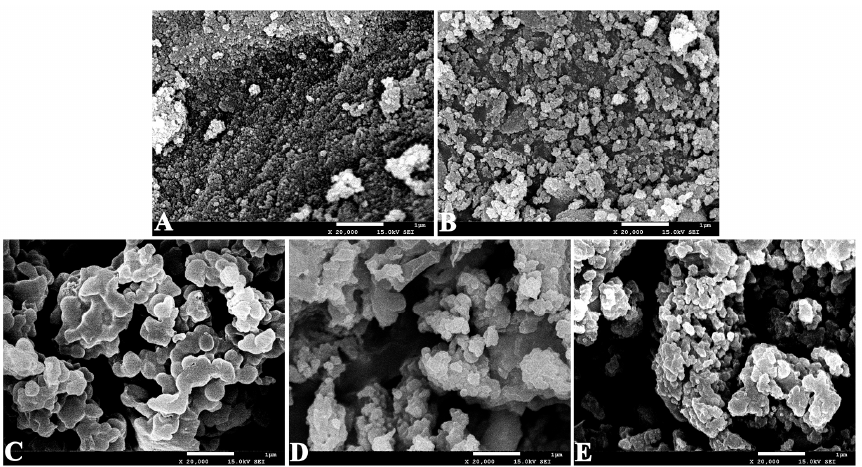
Figure 4. SEM images of ( A ) Fe 3 O 4 nanoparticles; ( B ) APTES-functionalized Fe 3 O 4 nanoparticles; ( C ) RML CLEAs; ( D ) magnetic RML CLEAs; ( E ) AOT-activated magnetic RML CLEAs.